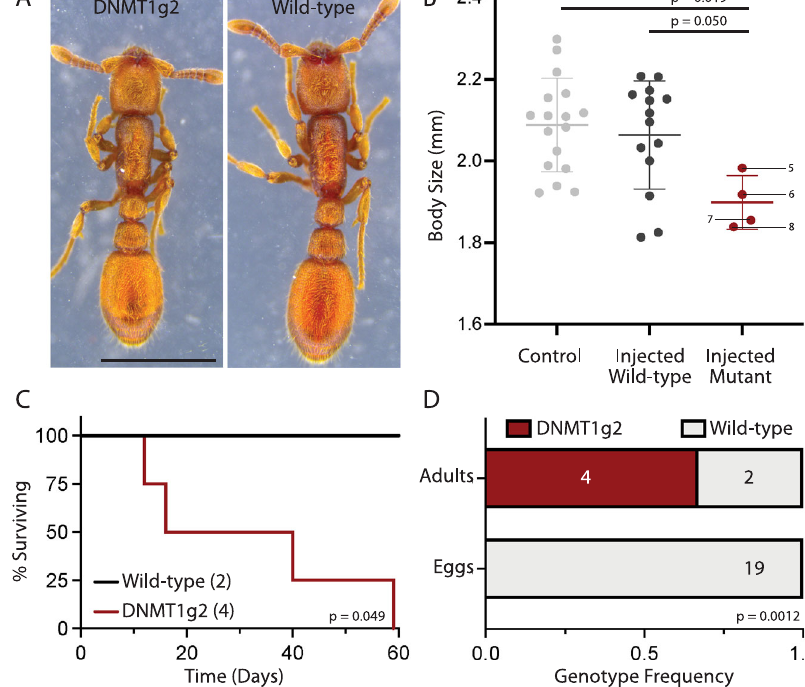
Fig. 2 | DNMT1 mutants develop normally, but have impaired survival and reproduction. A Images of DNMT1g2 mutant and wild-type animals. DNMT1g2 mutants complete development and are grossly indistinguishable from wild types in external anatomy despite lacking the functional DNMT1 enzyme (scale bar=1 mm). B Mutantsappearsmallerintotalbodysize(one-wayANOVA p =0.0248; n =4 mutant animals, 17 control animals, and 14 wild-type animals that were injected at the egg stage along with the mutants). Body size was calculated as the sum of the head, thorax, petiole, post-petiole and gaster lengths (Supplementary Fig. 3). Horizontal bars show pairwise comparisons using Tukey ’ s multiple comparisons